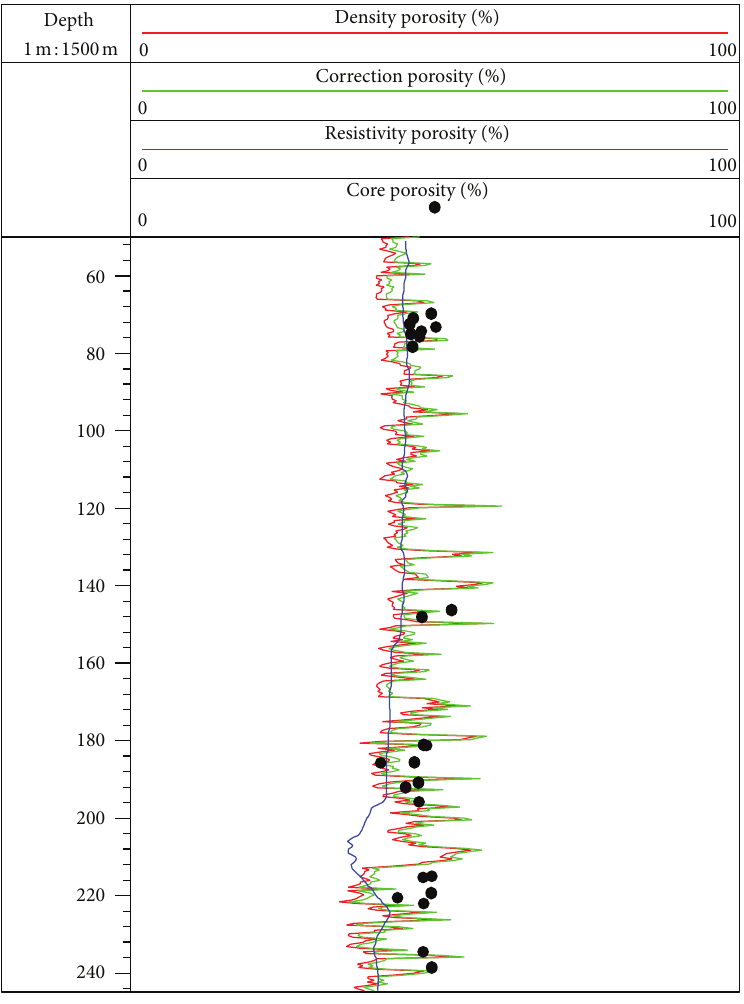
Figure 8: Comparison of estimation of sediment porosity made by different methods at site SH2. (The red curve is the porosity estimated by density log data; the bright green curve is the porosity considering the effect of shaly sediments; blue curve is the porosity estimated by resistivity log combined with Archie formula; the black dots are the porosity measured by core